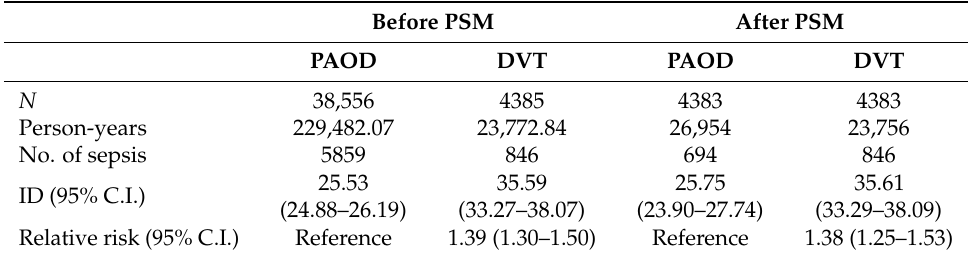
Table 2. Poisson regression of relative risk of PAOD and DVT.